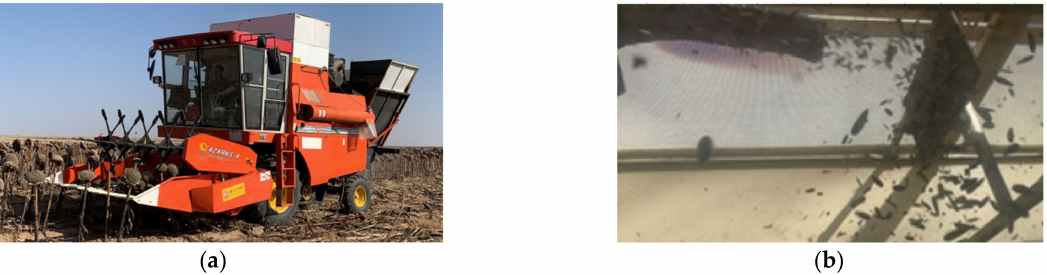
Figure 14. Sunflower harvesting field experiment: ( a ) 4ZXRKS-4 type self-propelled sunflower combine harvester; and ( b ) impact-type sunflower yield sensor. The output voltage signal of the impact-type sunflower yield sensor is shown in Figure